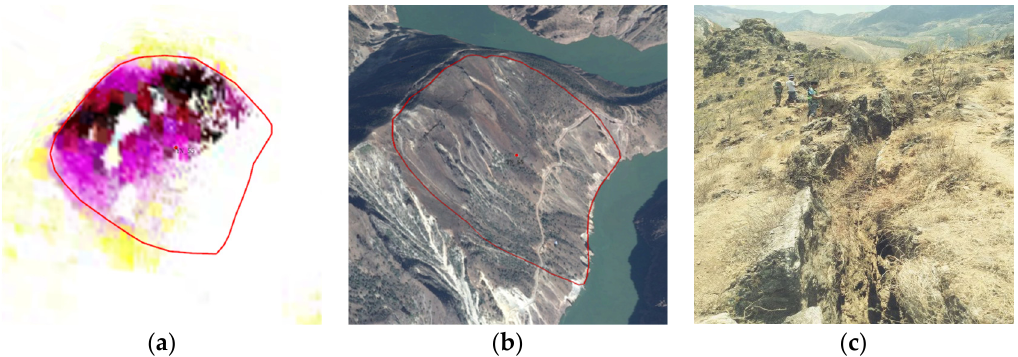
Figure 3. Deformation Results of the Descending Orbit.